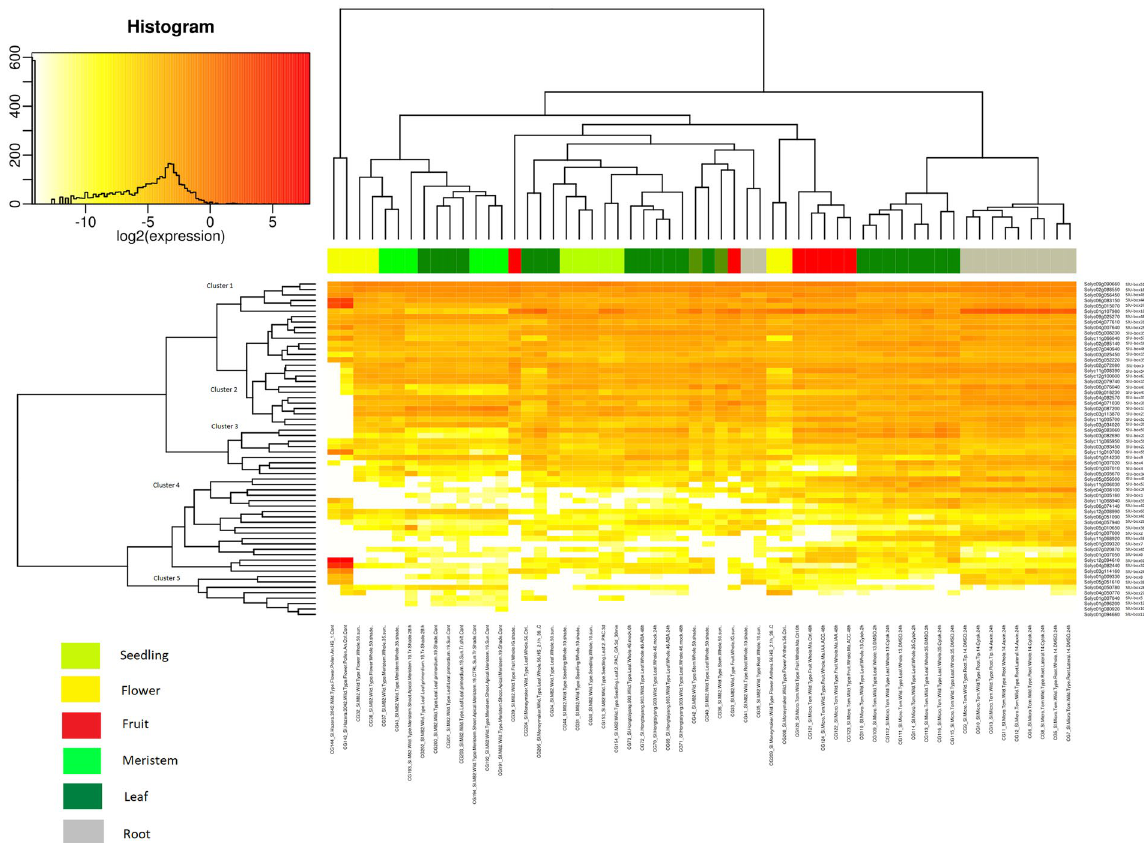
Figure 6. The gene expression level of the 62 U-box gene family members under abiotic stress and hormone- treated vegetative and reproductive tissues is represented by a heat map. (For detailed conditions refer Supplementary Table